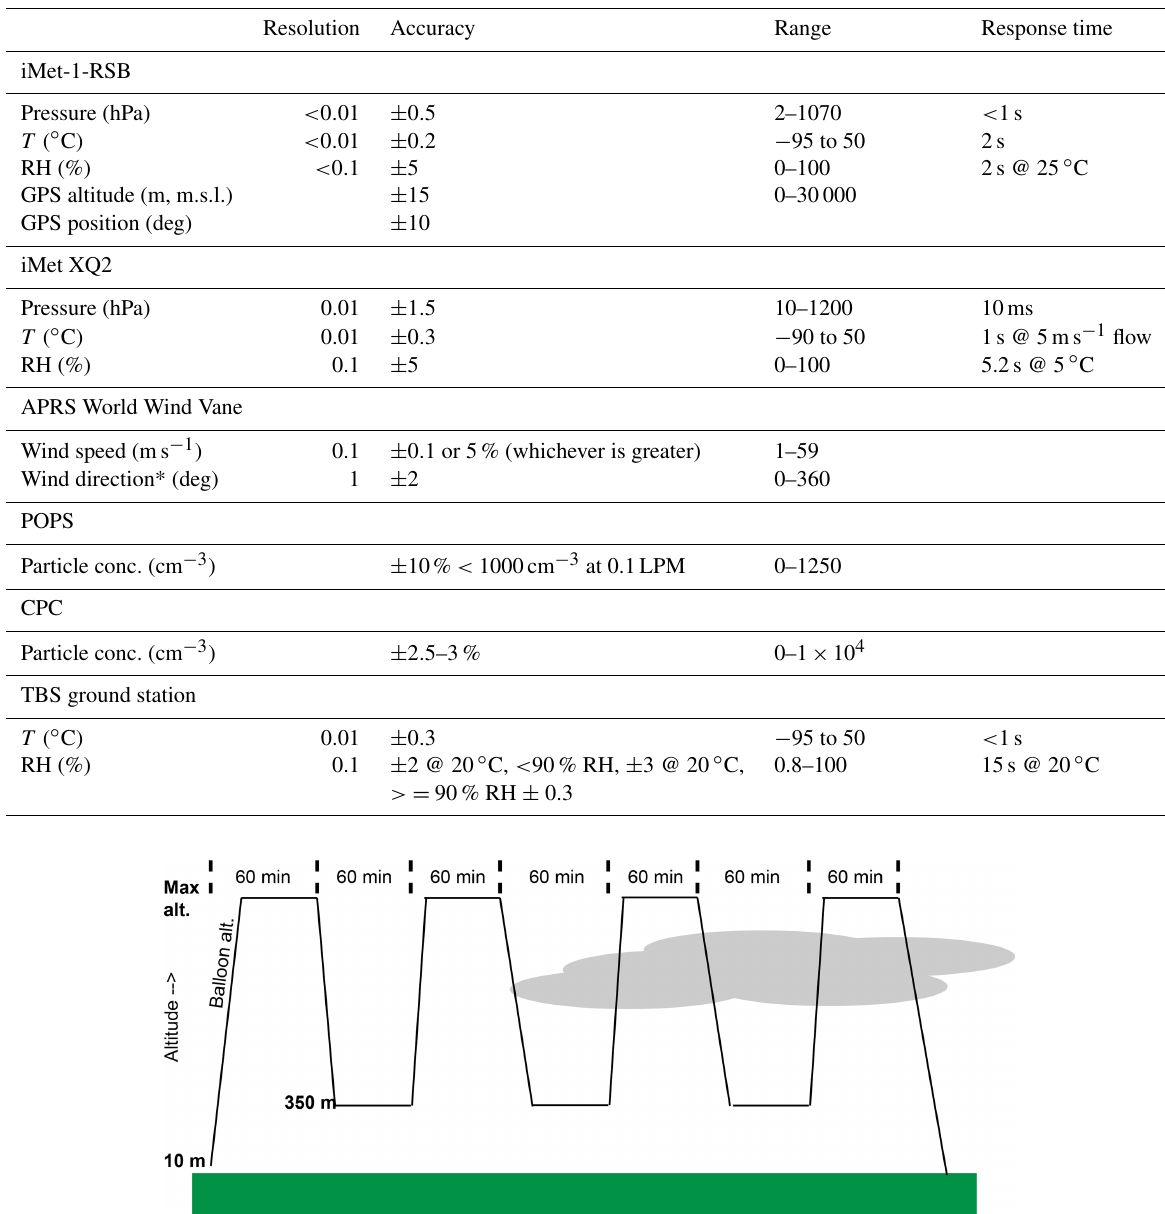
Table 1. Known performance characteristics for TBS instruments. The asterisk with wind direction denotes that these stated specifications have not been met in the Arctic environment at Oliktok Point.